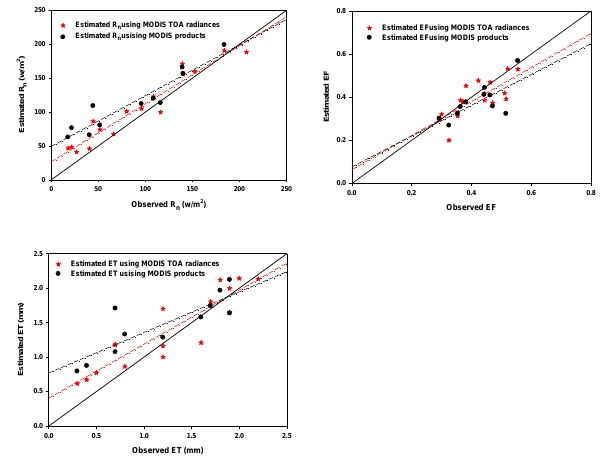
Fig. 5. Comparison of daily net radiation, evaporative fraction and ET estimated respectively from MODIS products and TOA Radiances with field observations (data from Nanchang experimental station).